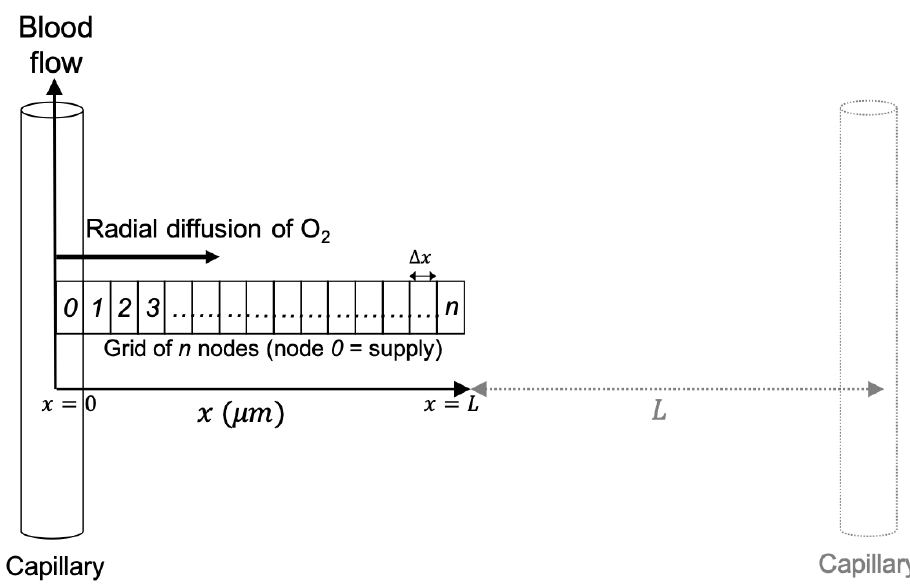
Figure 1. Schematic diagram of the oxygen diffusion-reaction model, showing radial diffusion from a capillary along an orthogonal grid of nodes. An adjacent capillary is shown, where the distance between two capillaries is 2 L . A node width of ∆ x = 1µm and system length of L = 50µm was used for all simulations. The figure is reproduced from Rothwell et al.